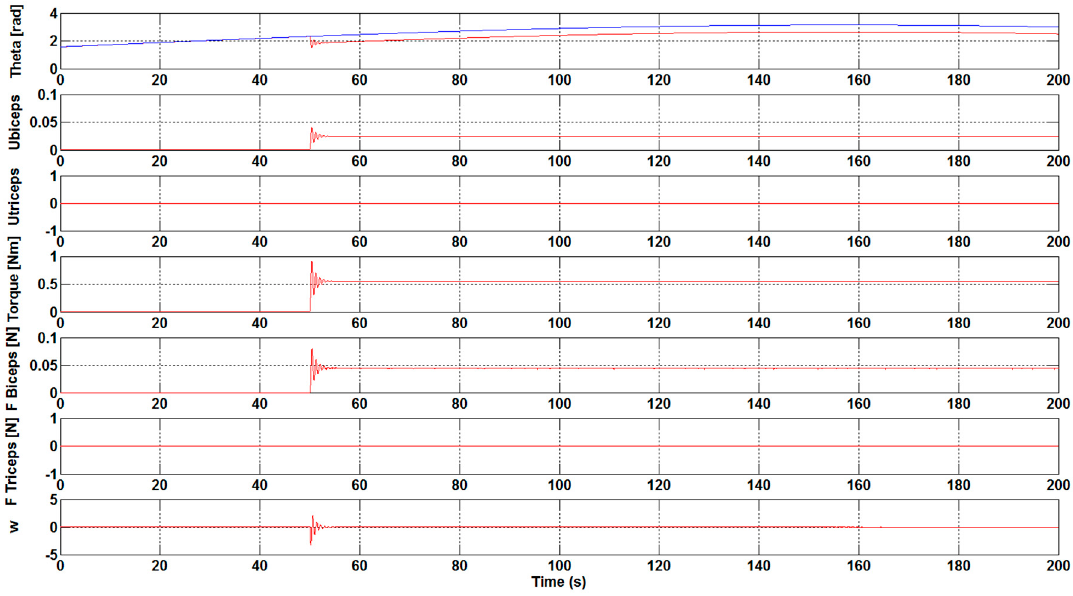
Figure 8. Results with the optimization algorithm and with the application of a load.